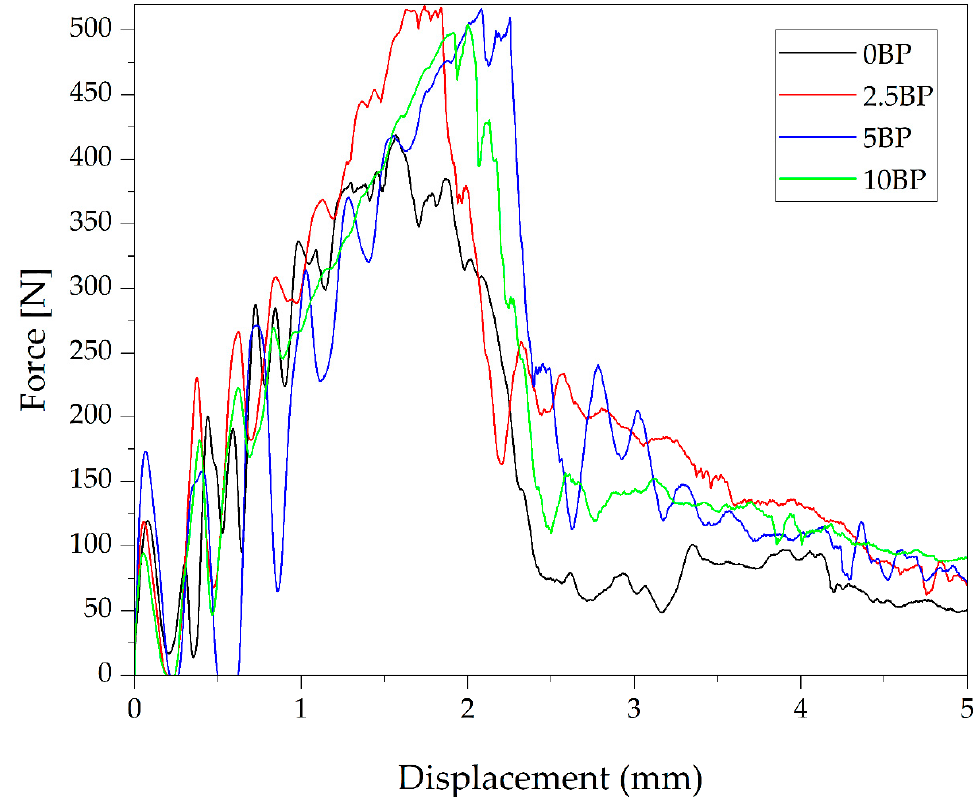
Figure 4. The load–displacement curves of the investigated composites with basalt powder. For composites modified with basalt microfiber, the impact values ranged from 45 to 59 [kJ/m 2 ]. The highest value was recorded for the sample with the highest BF additive content. The image of composites after the impact test and photos of the break point are shown in Figure 5. The presence of rigid basalt microfibers in the epoxy matrix leads to the improvement of its stiffness and reduces its brittleness. In addition, composites con- taining 10 wt. % basalt microfibers were characterized by the smallest area of destruction as well as their structure not being completely damaged in comparison to samples 0 BF and 2.5 BF (Figure 5). These results show that modifying the epoxy matrix is an effective method of improving the mechanical behavior of fiber composites [33].